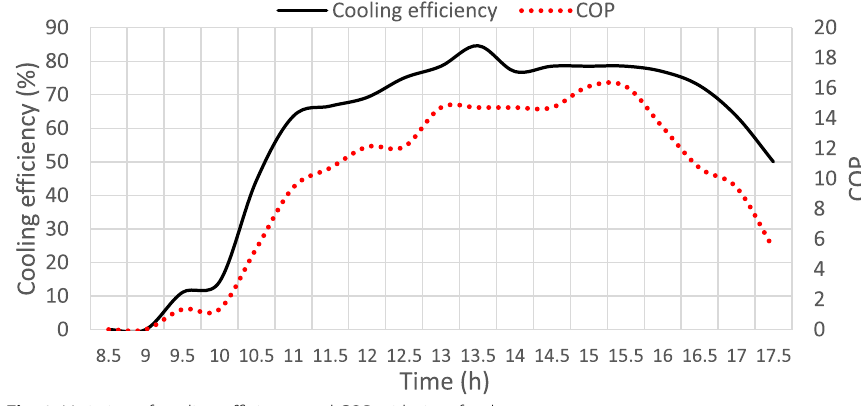
Fig. 9 Variation of cooling efficiency and COP with time for day 1